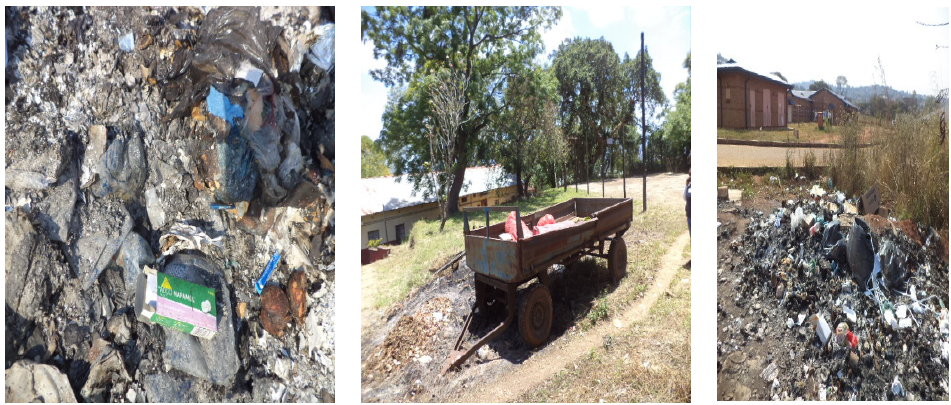
Figure 7. Burning sites within Vhembe healthcare facilities. (Photos taken during field work).